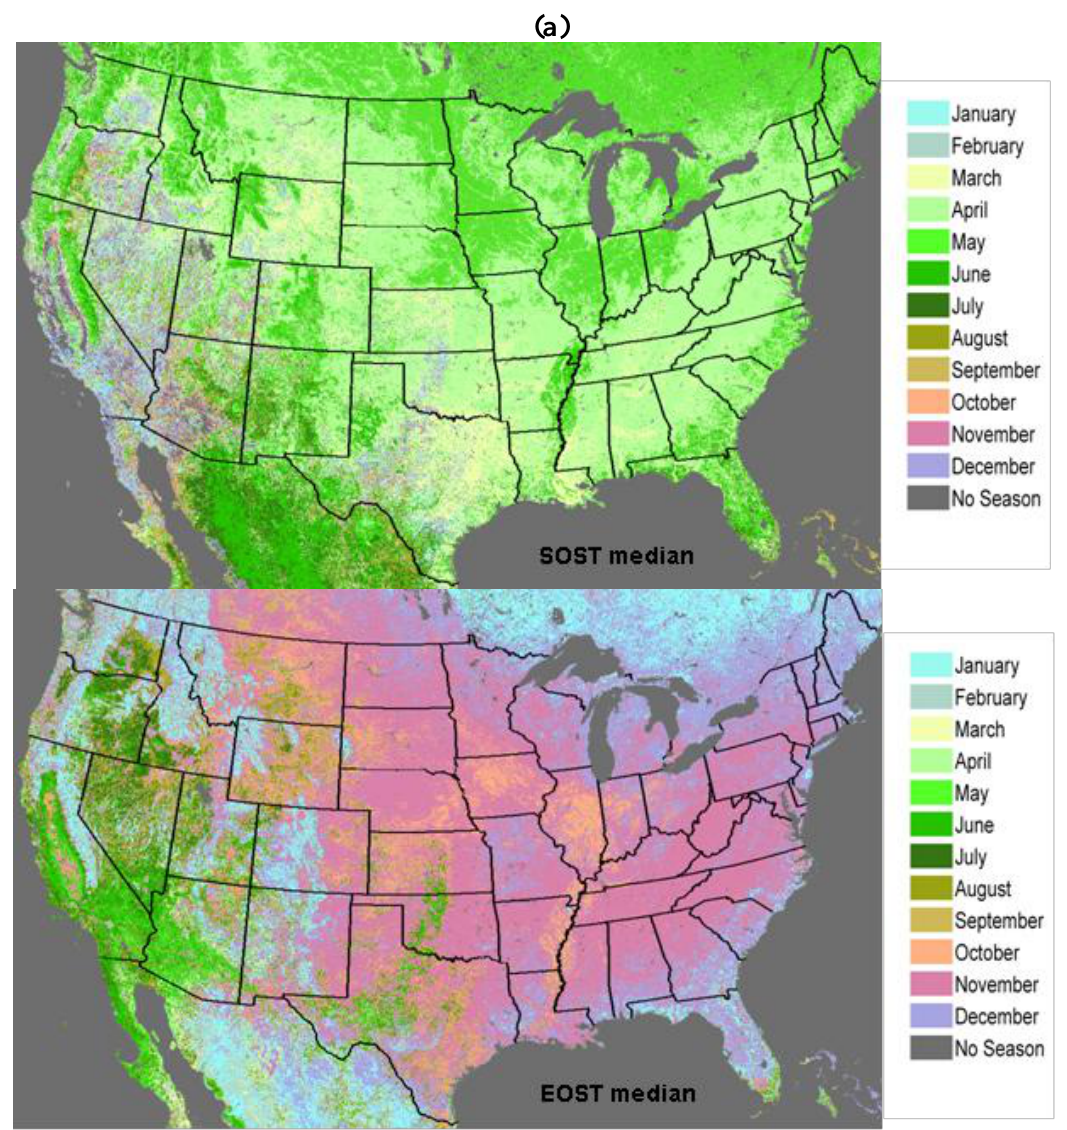
Figure 1 . Examples of phenological metrics maps derived from MODIS NDVI time-series data between 2000 and 2004. The DEM was used as a proxy for climate. (a) SOST and EOST; (b) SOSN and EOSN; (c) TIN and DEM